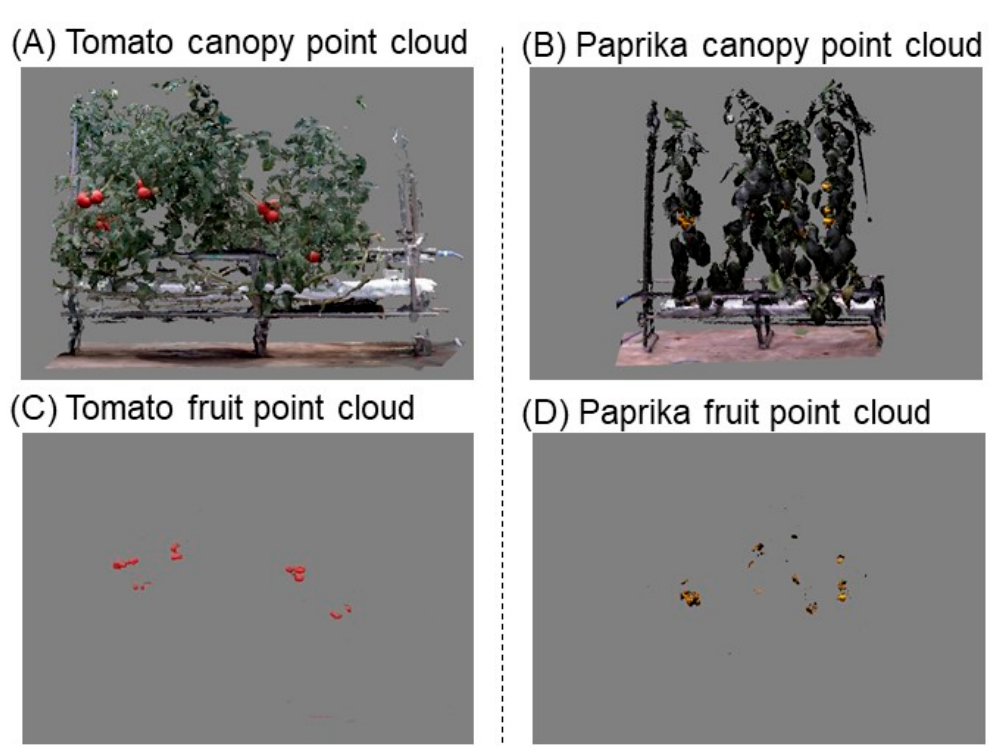
Figure 5. Plant canopy and fruit point cloud data. Tomato canopies for estimation of fruit weight were scanned using the 3D scanner (DPI-8X, Opt Technologies Co., Ltd., Tokyo, Japan) from 14 August to 5 September 2019 ( A ). Paprika canopies for estimating fruit weight were scanned from 28 August to 30 2019 ( B ). Fruit point cloud data were detected from the canopy point cloud data using the RGB value. Point cloud data of tomato fruits fulfilling R > 140, G < 100, and B < 100 were acquired ( C ). Point cloud data of paprika fruits fulfilling R > 150, G > 110, and B < 50 were obtained ( D ). Point cloud data were obtained using OPT Cloud Survey (Opt Technologies Co., Ltd., Tokyo, Japan).